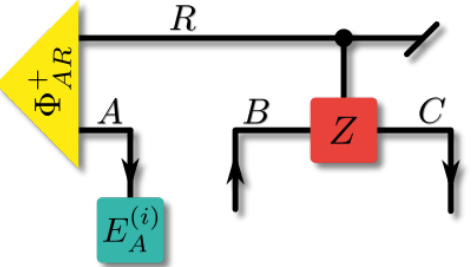
Figure 5: Alice controls the entanglement between Bob and Charlie.